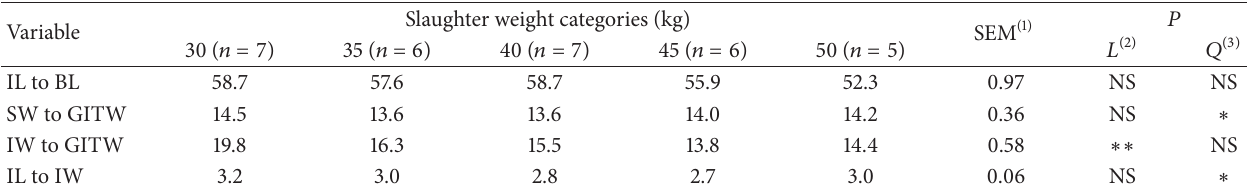
Table 4: Ratios between the whole GIT and selected segments in the Karayaka ram lambs slaughtered at different weights. Slaughter weight categories (kg) Variable